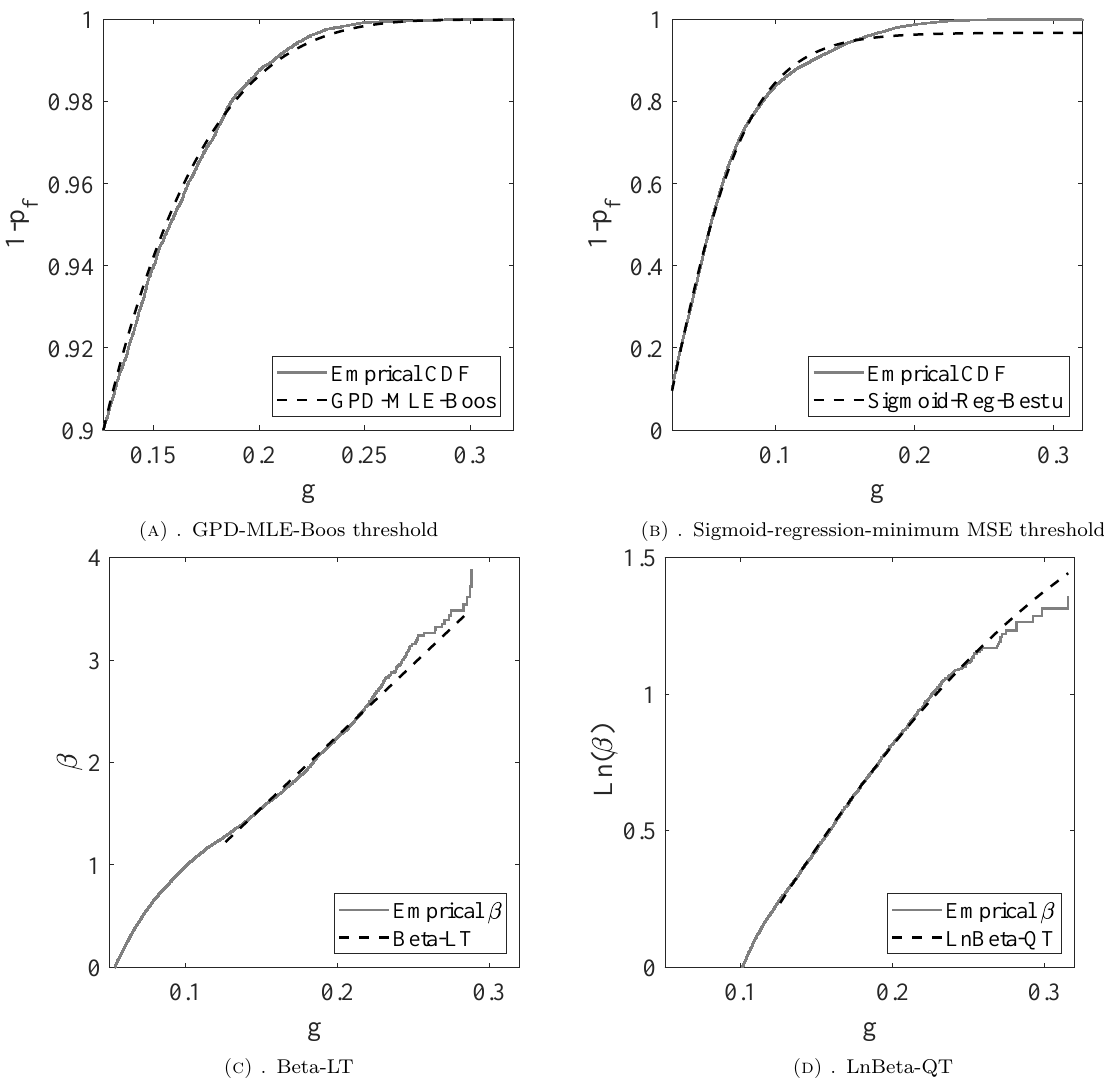
Figure 5. Example of fitted tail models for bridges with span length of 30 m.